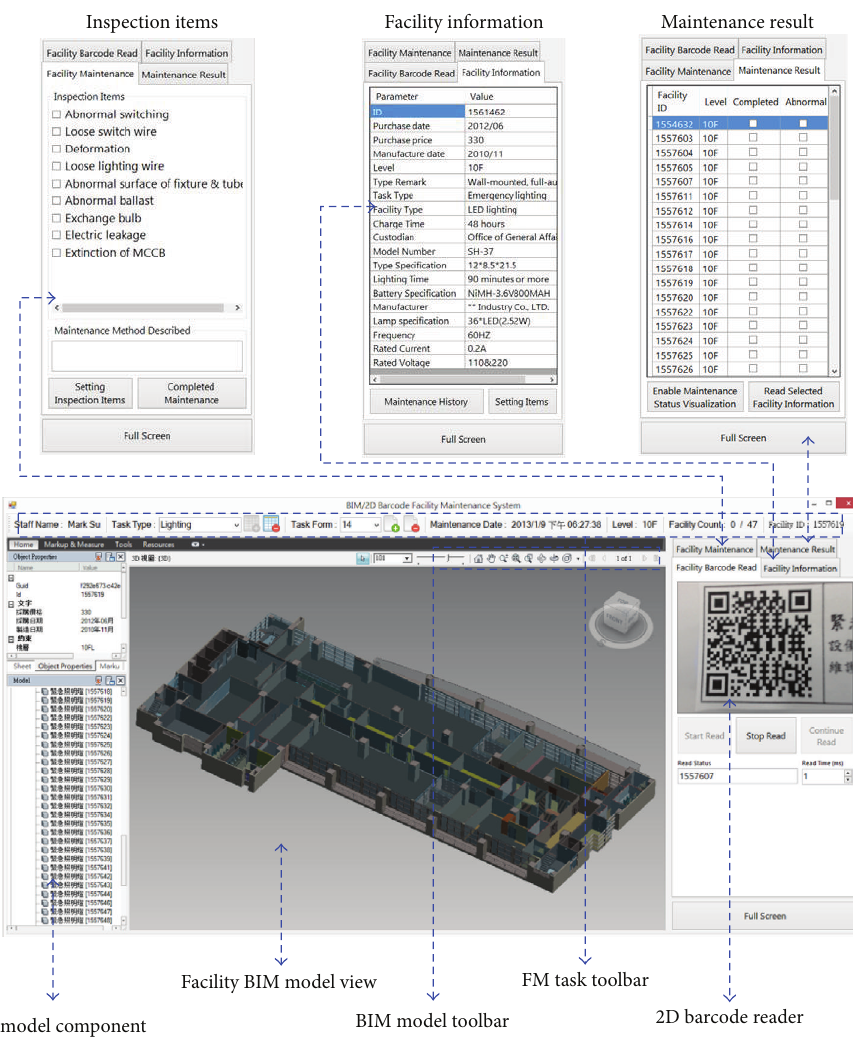
Figure 5: GUI of the BIMFM